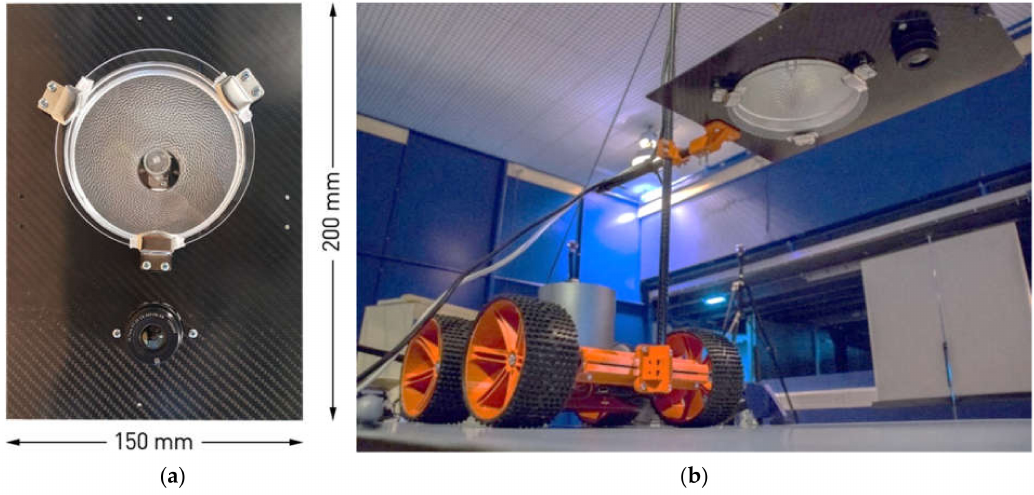
Figure 2. IRT module ( a ) dimensions and arrangement and ( b ) mounted on the prototype Vortex Robot Platform developed by Luleå University of Technology [31,32] for automated aircraft skin inspection of BVID by Pulsed Phase-informed Lock-in Thermography